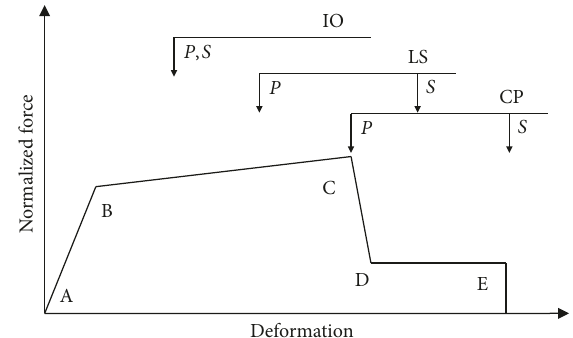
Figure 7: Idealized full backbone curve, acceptance criteria according to ASCE 41-13